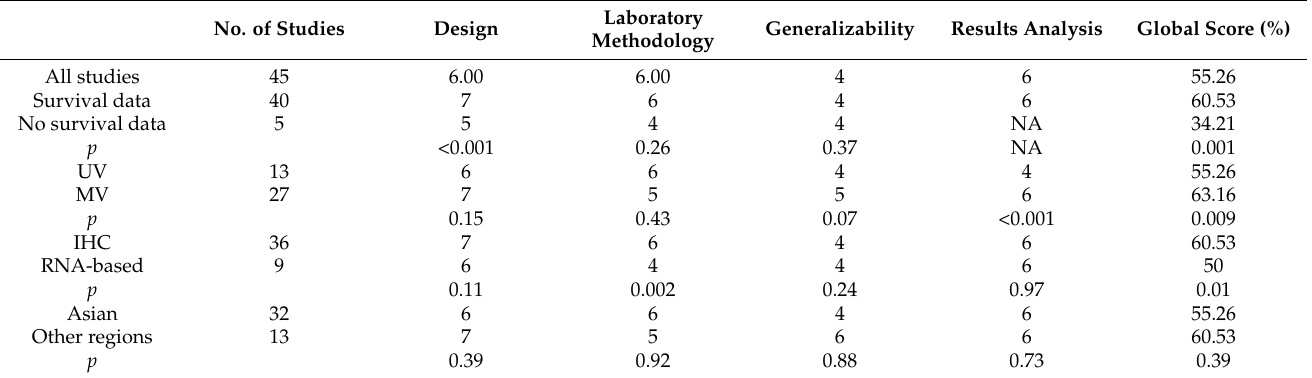
Table 2. Study quality assessment according to the ELCWP